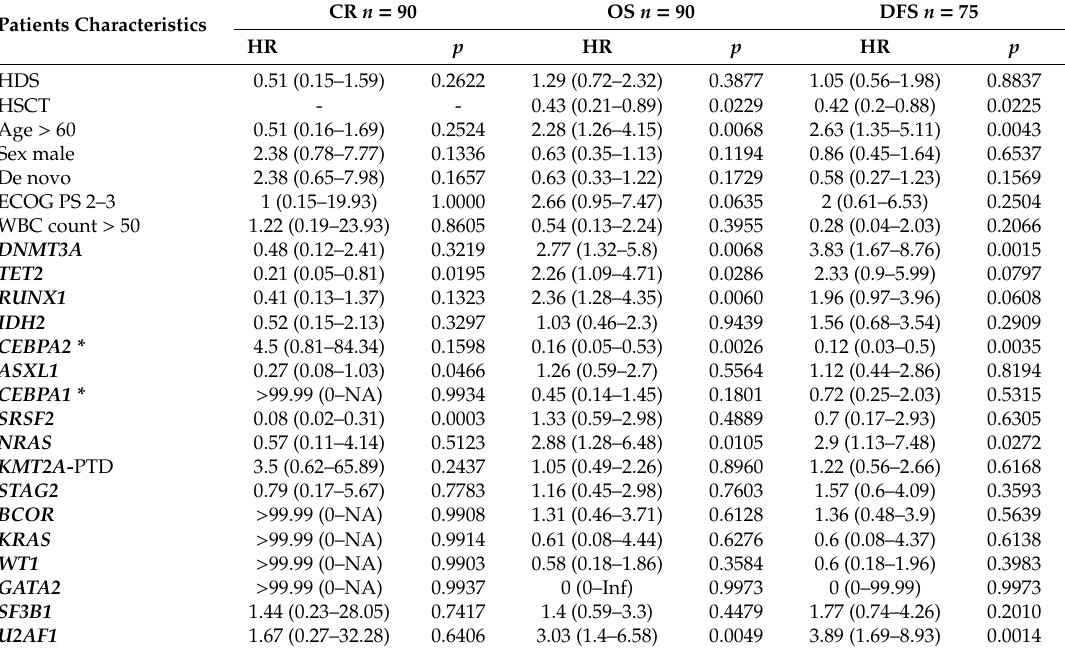
Table 4. Univariate analysis for patients characteristics, treatments and mutations in patients lacking both FLT3 -ITD and NPM1 alterations ( n = 90 and n = 75 achieving CR). Patients Characteristics